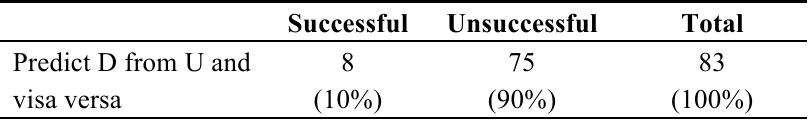
Table 8. Observed and predicted data on the individual